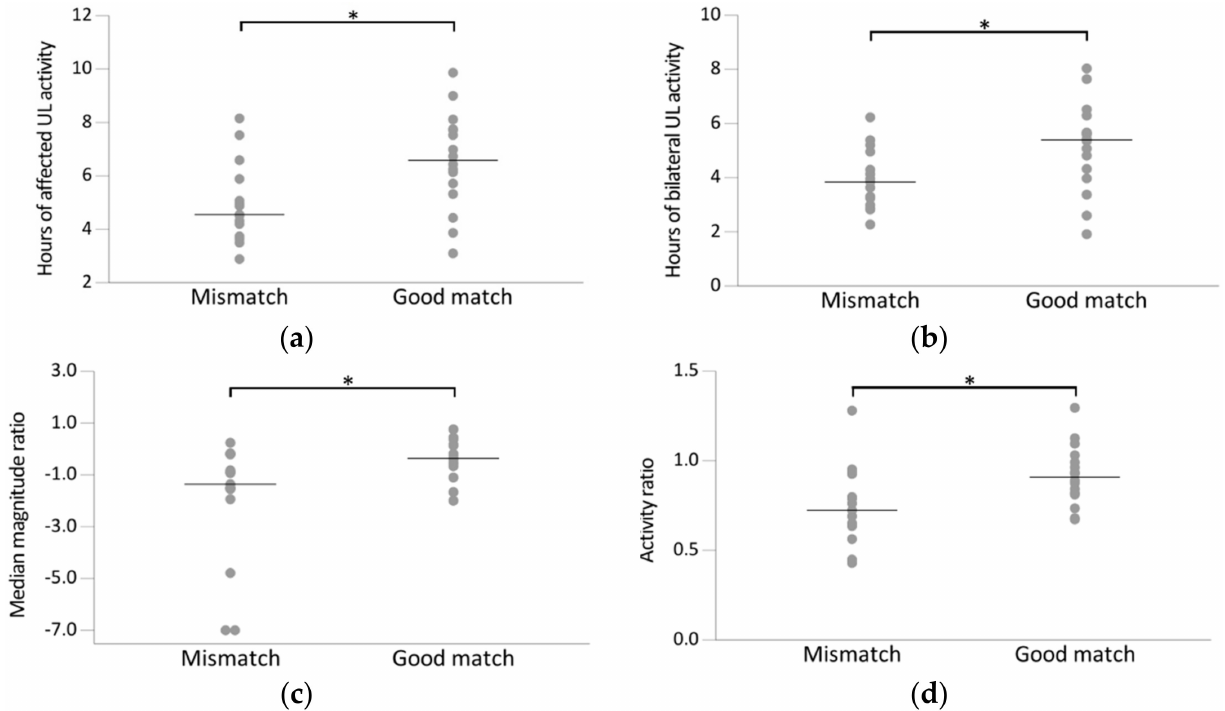
Figure 2. Scatterplot of accelerometry outcome variables for the mismatch group ( n = 15; FMA-UE >50, SIS-Hand ≤ 75) and good match group ( n = 16; FMA-UE >50, SIS-Hand >75). Every dot represents the raw value of a patient; raw mean ( a – c ) or median scores ( d ) indicated with horizontal bar. Horizontal brackets indicate significant differences between two groups ( p < 0.05). ( a ) Hours of affected UL activity, ( b ) hours of bilateral UL activity, ( c ) median magnitude ratio, ( d ) activity